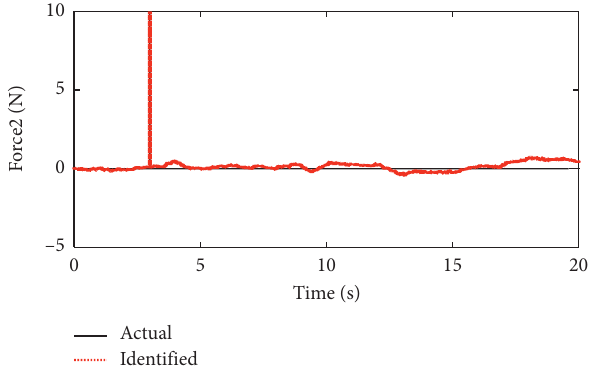
Figure 11: Identification of external load u